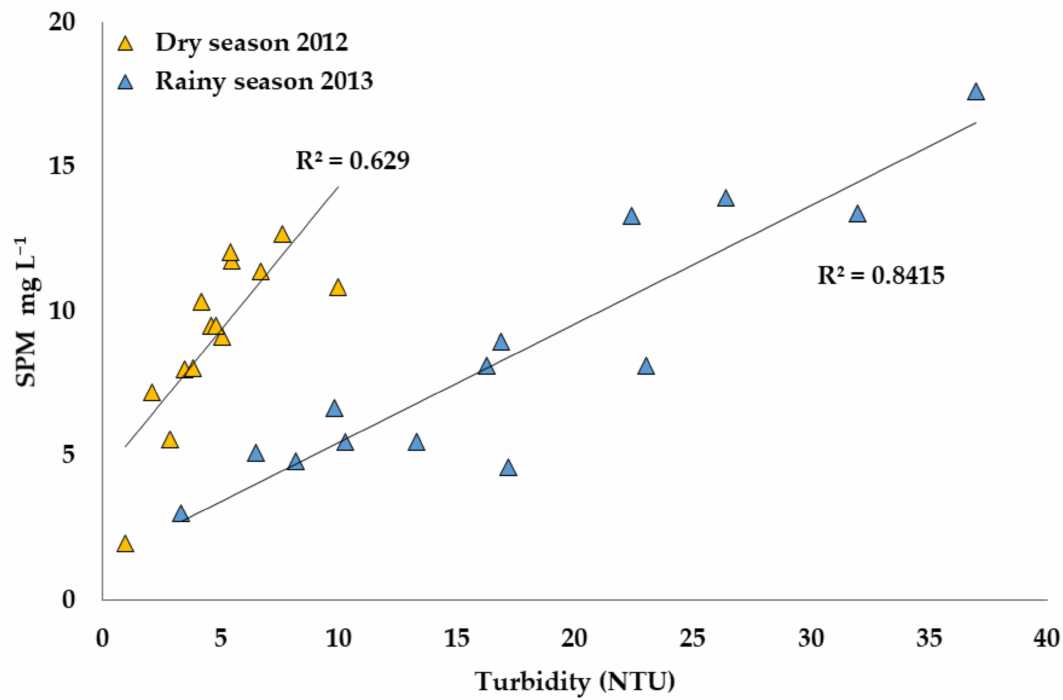
Figure 4. Relation between SPM and Nephelometric Turbidity Unit (NTU) in the dry season in September 2012 and the rainy season in March